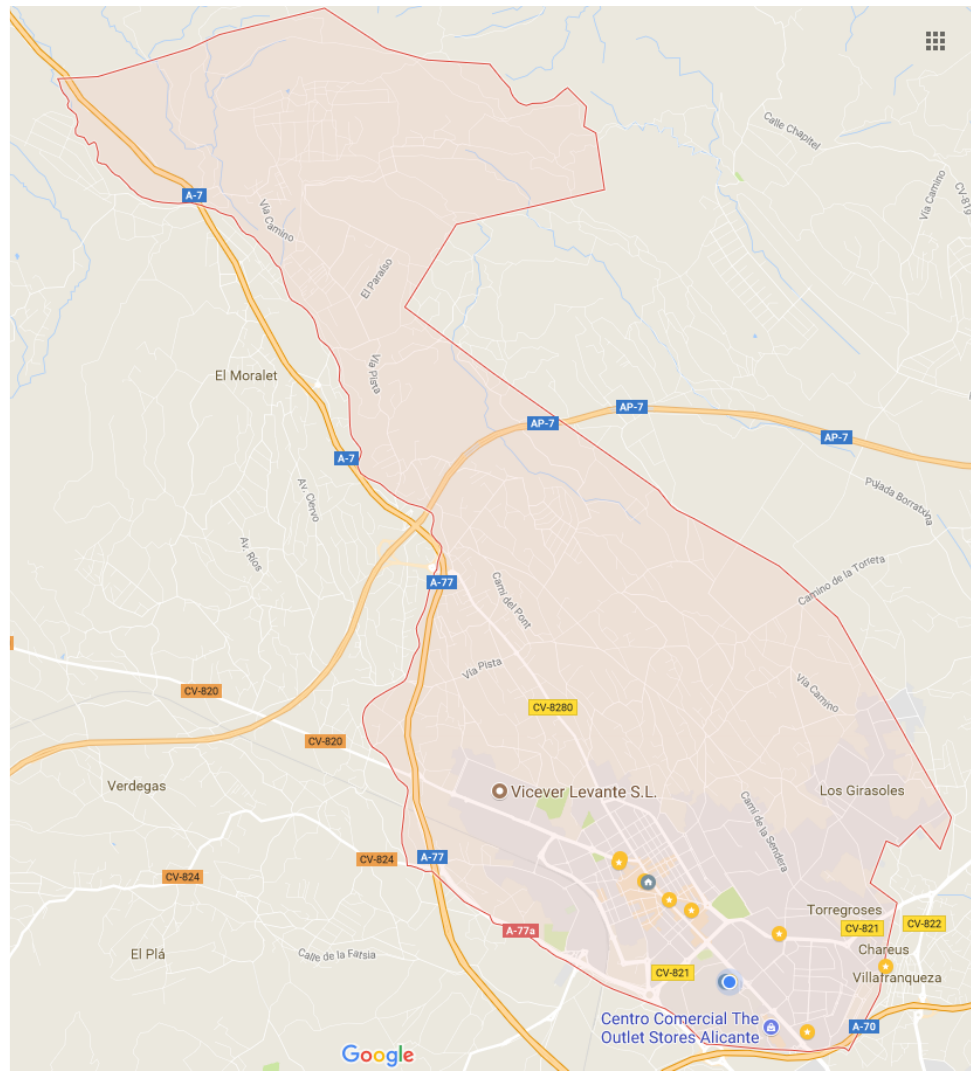
Figure 6. Map of San Vicente del Raspieg, the city used in this study (source: Google